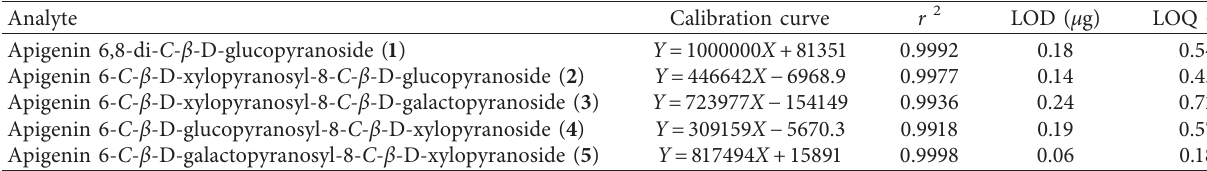
Table 2: Calibration curve, LOD, and LOQ of the five investigated compounds. Analyte